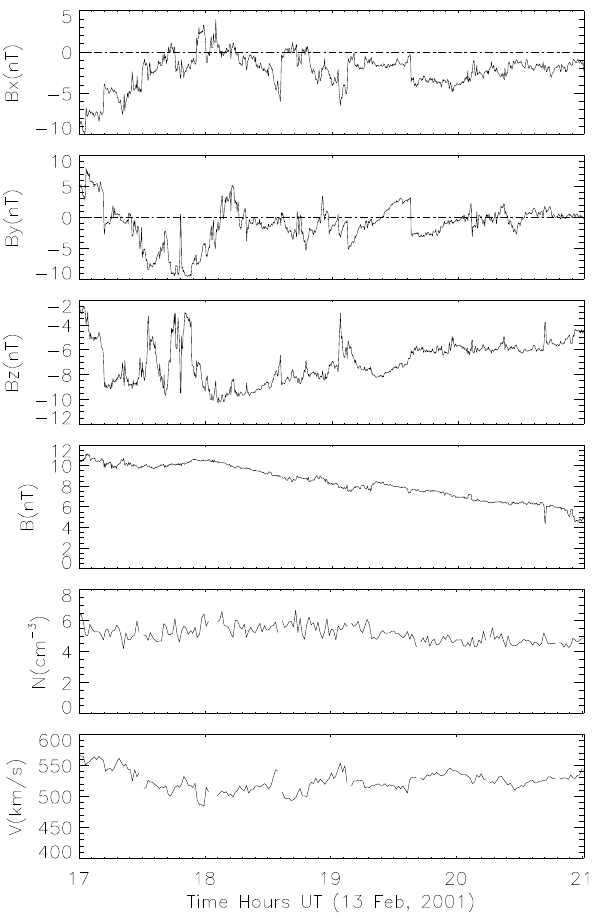
Fig. 9. The solar wind conditions measured by the ACE space- craft between 17:00 and 21:00UT on 13 February 2001. The six panels show B X , B Y , B Z , B , N and V ,